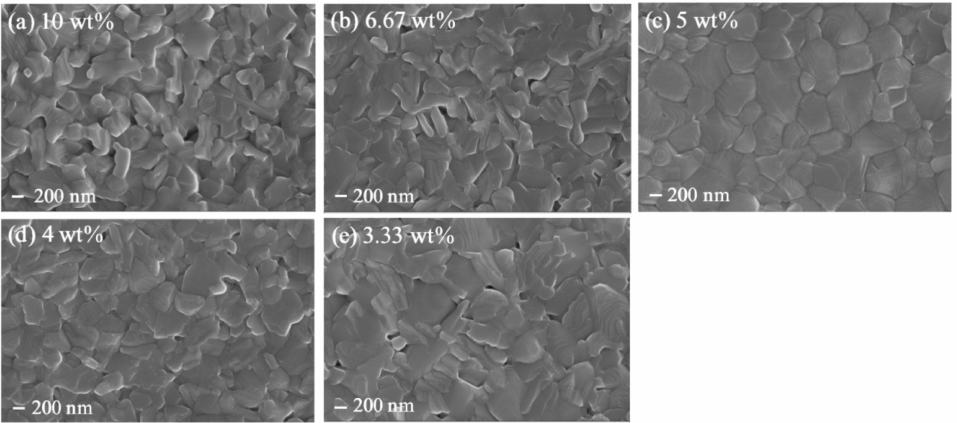
Figure 1. SEM images for the perovskite layers formed on different SnO 2 layers. SnO 2 colloid solutions of different concentrations: ( a ) 10 wt.%, ( b ) 6.67 wt.%, ( c ) 5 wt.%, ( d ) 4 wt.%, and ( e ) 3.33